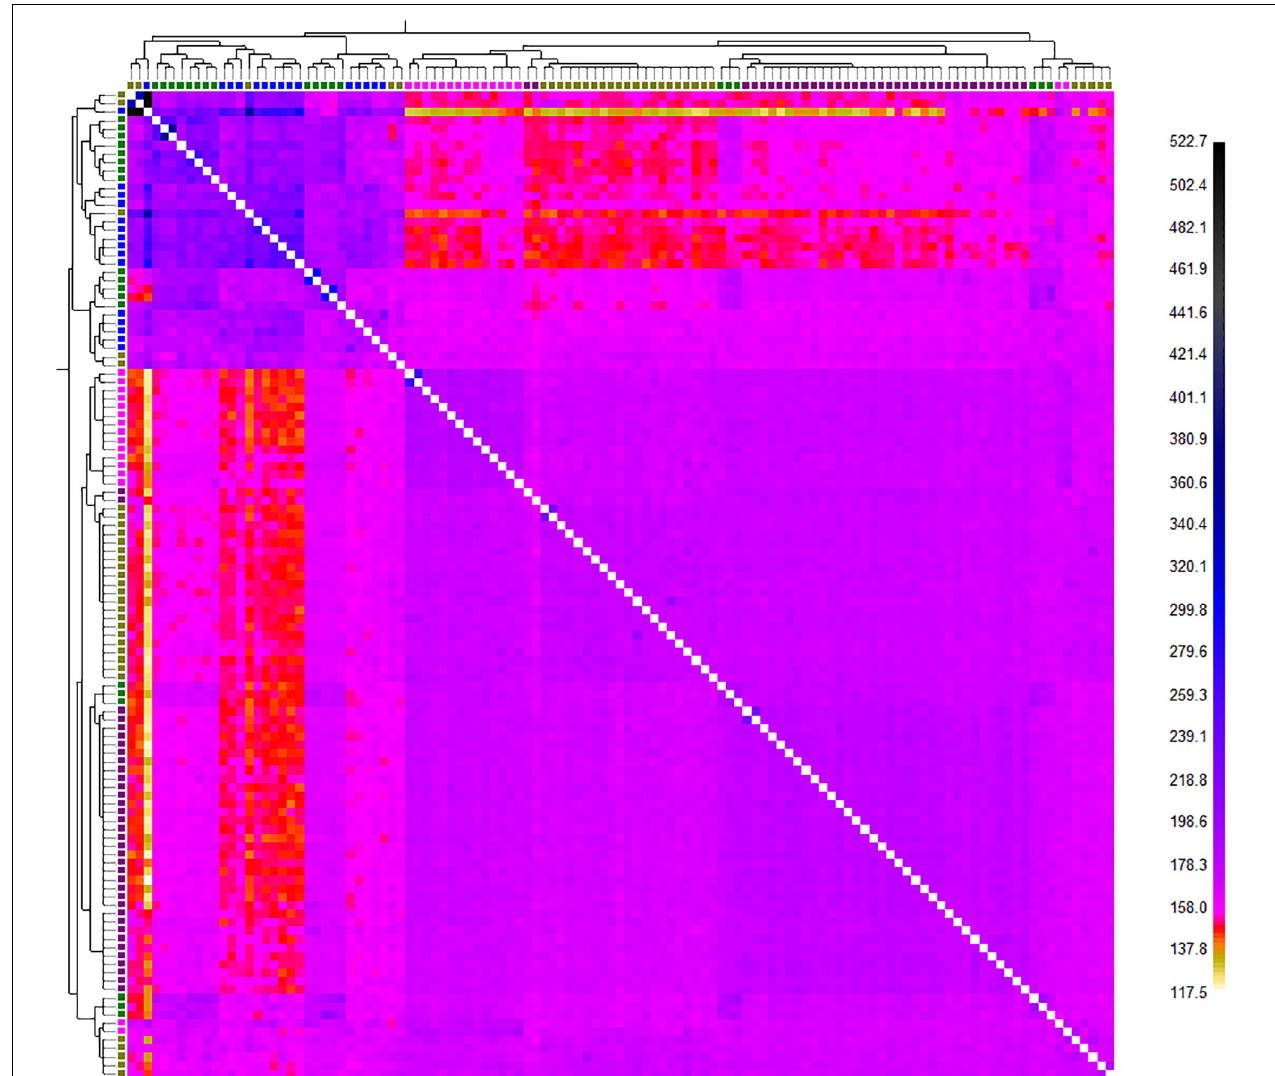
FIGURE 5 | Finestructure classification based on the obtained SNP markers from genotyping-by sequencing (GBS) on C. carpio across the southern Caspian basin (different colors in the X and Y axis trees represent different populations; Green: Anzali, Purple: Anzali-wetland, Olive: Gomishan, Pink: Miankaleh, and Blue: